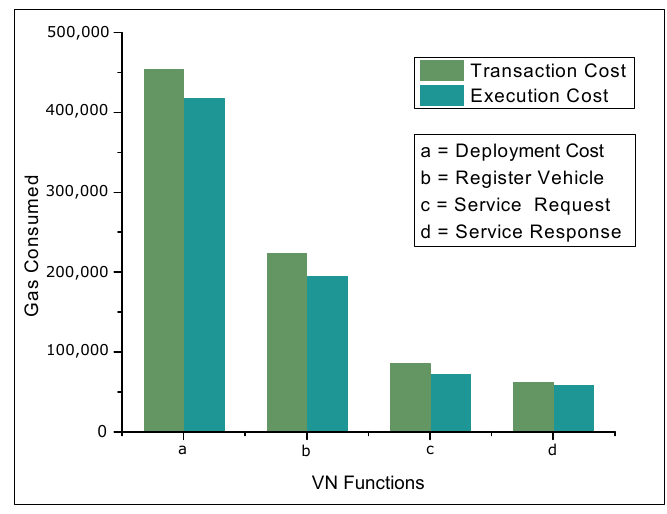
Figure 6. Gas Consumption for VN Functions.